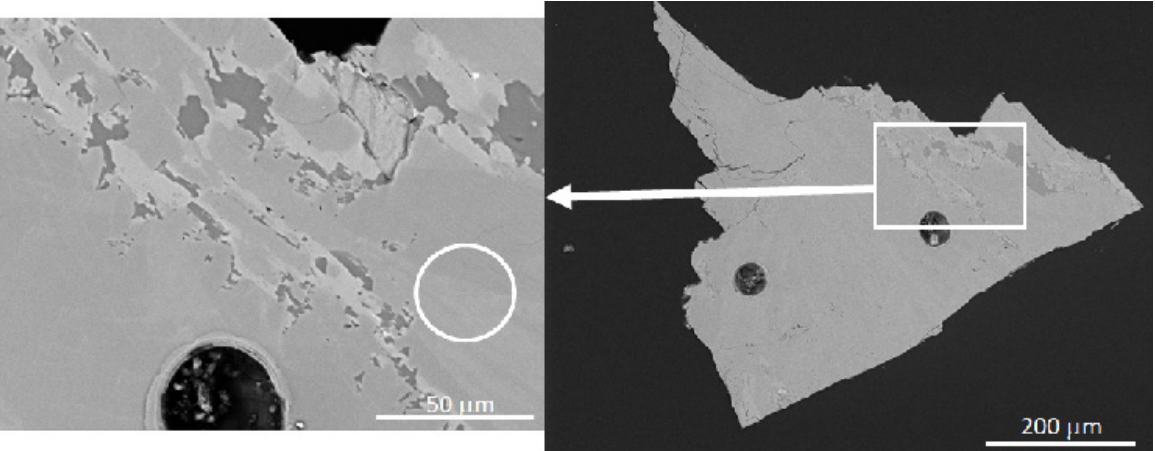
Figure 6. BKSE image of sample 6 and enlargement.